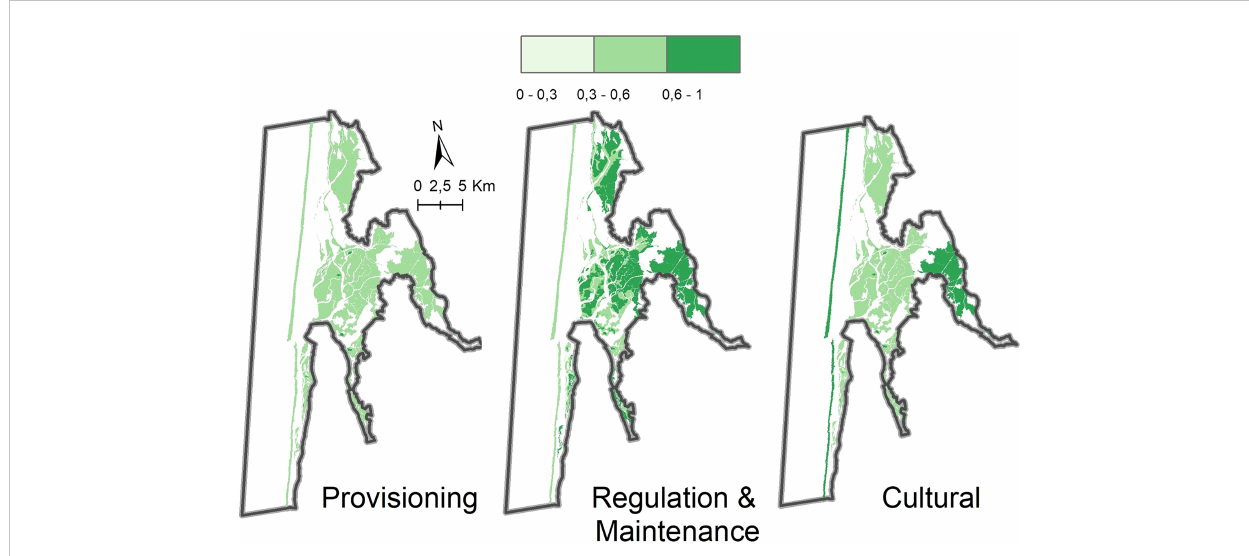
FIGURE 6 Ecosystem-service supply maps for the Ria de Aveiro. Values are the cumulative sum of the availability scores obtained from expert valuation on the identi fi ed habitats ’ ecosystem services availability in three categories: provisioning, regulation and maintenance, and cultural. Scores were normalized from 0 to 1. See Supplementary Table 2 for further detail.